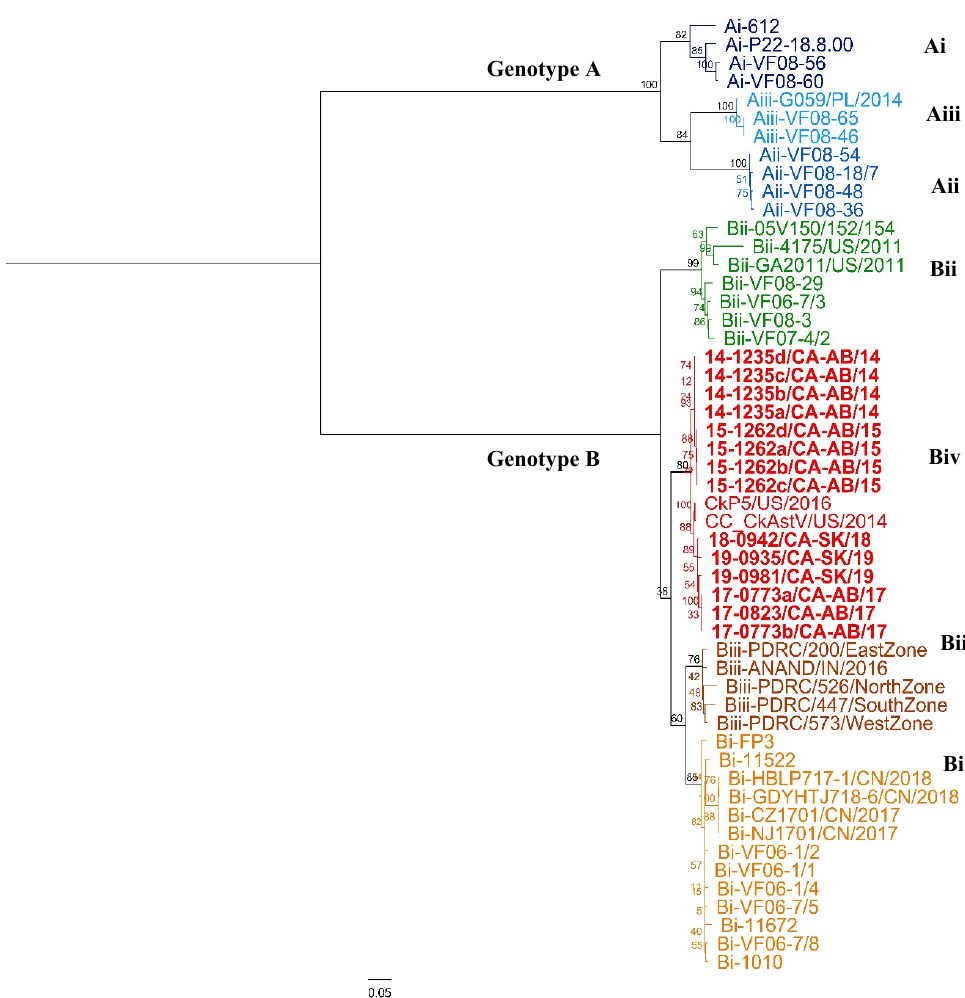
Figure 4. Amino acid ML phylogenetic tree of 52 ORF2 CAstV sequences. Different colors indicate different genotypes according to ORF2 analysis described by Smyth 2017 [5]. The included sequences are described in Supplementary Table S1.